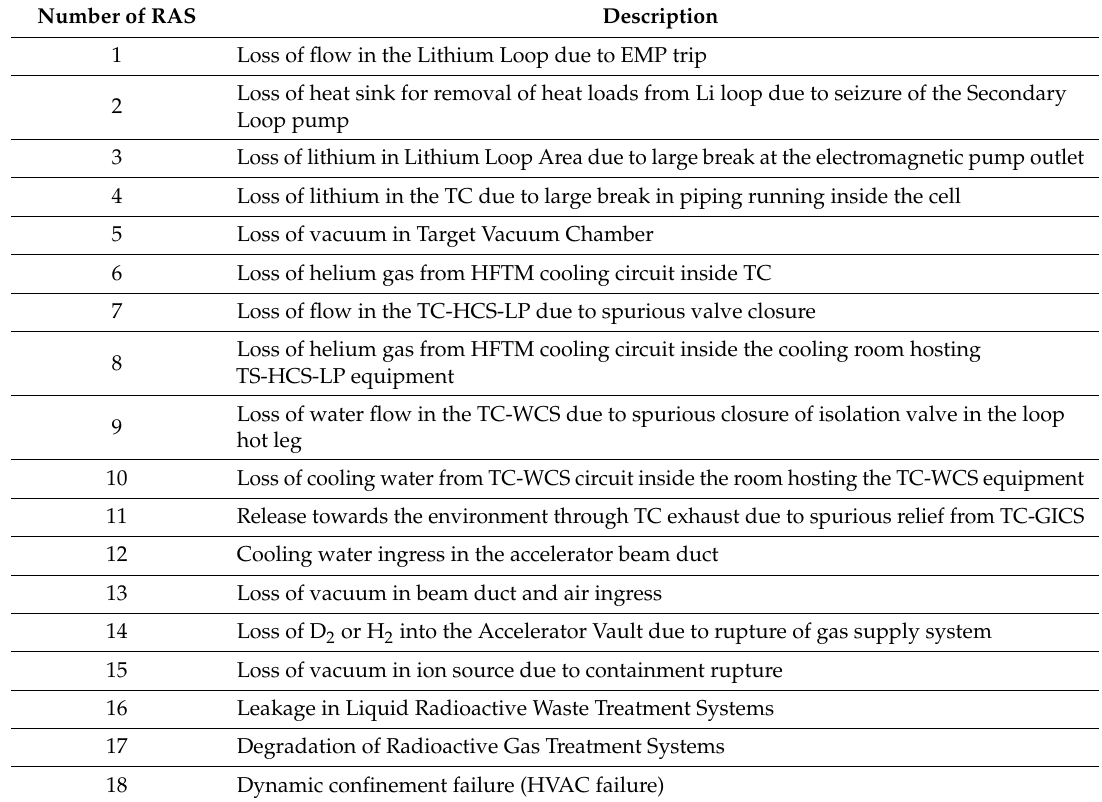
Table 2. The present list of Reference Accident